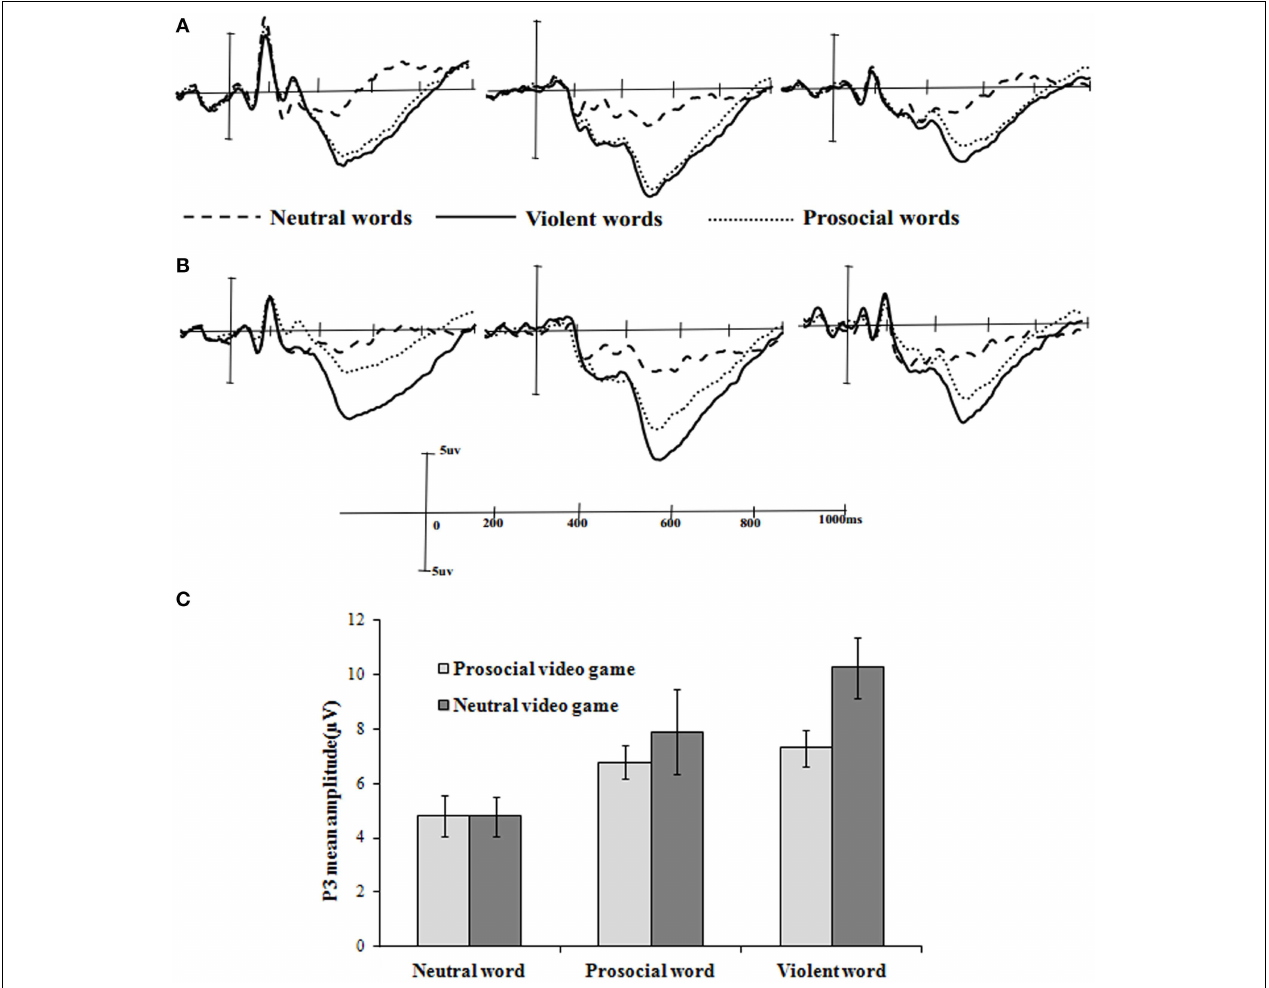
and violent words. (C) P300 results for prosocial and neutral video game playing. There was an interactive effect of game type and word type. P300 amplitude was smaller in the prosocial video game group for violent words compared to the neutral video game group; however, no significant effect was found for neutral and prosocial words. P300 amplitude on the Y-axis was calculated by averaging of Pz, P3, and P4 electrodes readings. Once again error bars were ± 1 standard